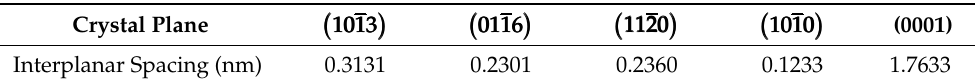
Table 1. Interplanar spacings of reference